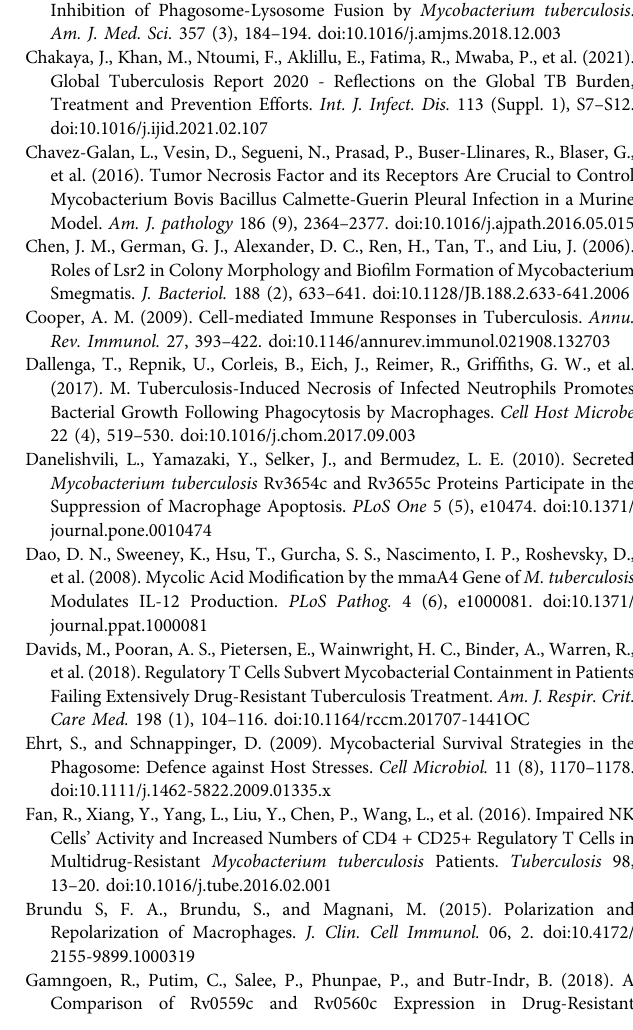
Supplementary Table S1 | List of primers used for RT-PCR